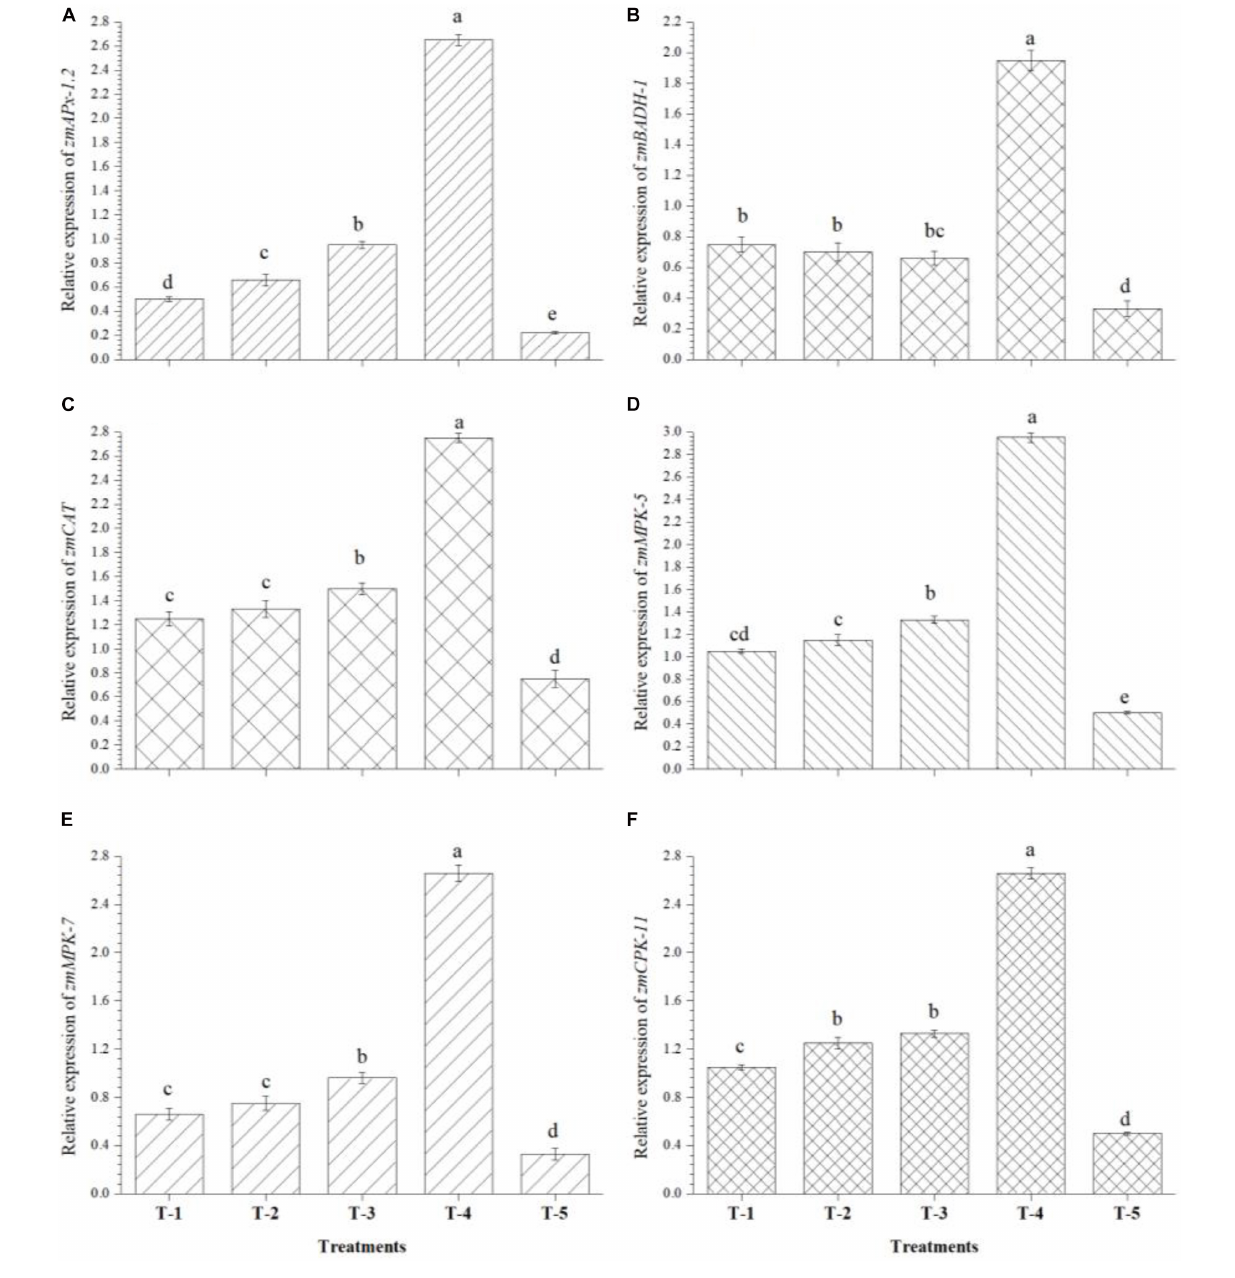
FIGURE 6 | Effects of seed bio-inoculation on expression profile of genes (fold change) related to antioxidants and abiotic stress tolerance in the maize leaves grown in saline sodic soil at 45 days of sowing. (A) Relative expression of zmAPx-1.2 , (B) relative expression of zmBADH-1 , (C) relative expression of zmCAT , (D) relative expression of zmMPK-5 , (E) relative expression of zmMPK-7 , and (F) relative expression of zmCPK-11 . Treatments were as follows: T 1 — B. safensis MF-01, T 2 — B. altitudinis MF-15, T 3 — B. velezensis MF-08, T 4 — B. safensis MF-01 + B. velezensis MF-08 + B. altitudinis MF-15, and T 5 —control (untreated). Data are mean ( n = 10) and vertical bar represents standard deviation. Data with different letters show significant difference in column data in randomized block design test at p < 0 . 05 under Duncan’s multiple range